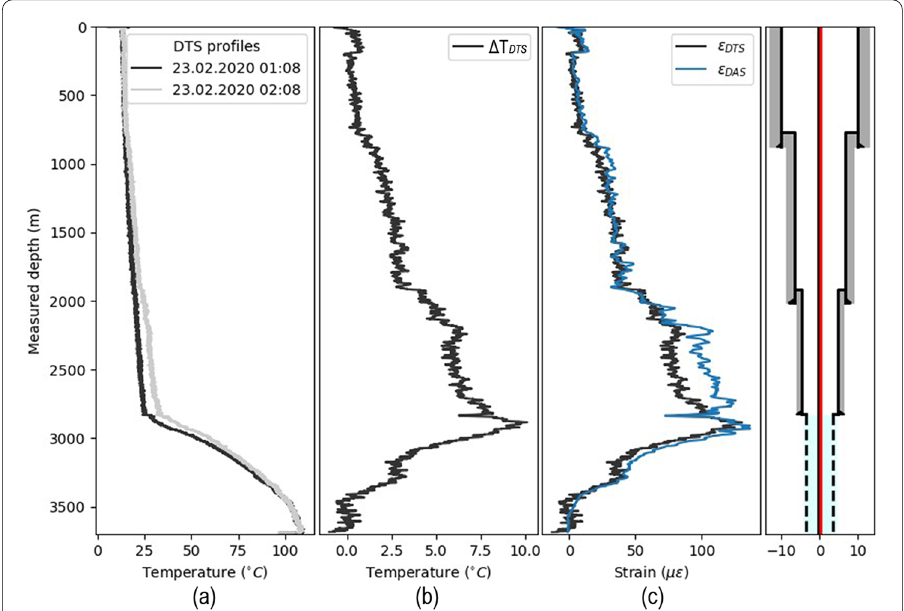
Fig. 11 Theoretical thermal expansion from DTS data and measured thermal expansion from DAS data after well shut-in,